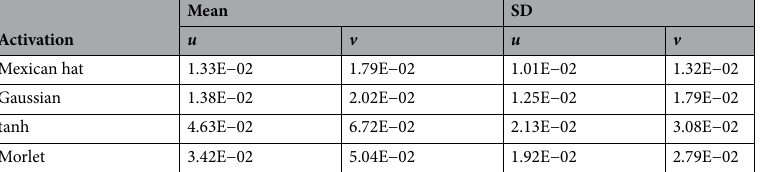
Table 2. Average and SD of relative L 2 error of the proposed method in solving linear coupled equation using different activation function compared against the analytical solution over 10